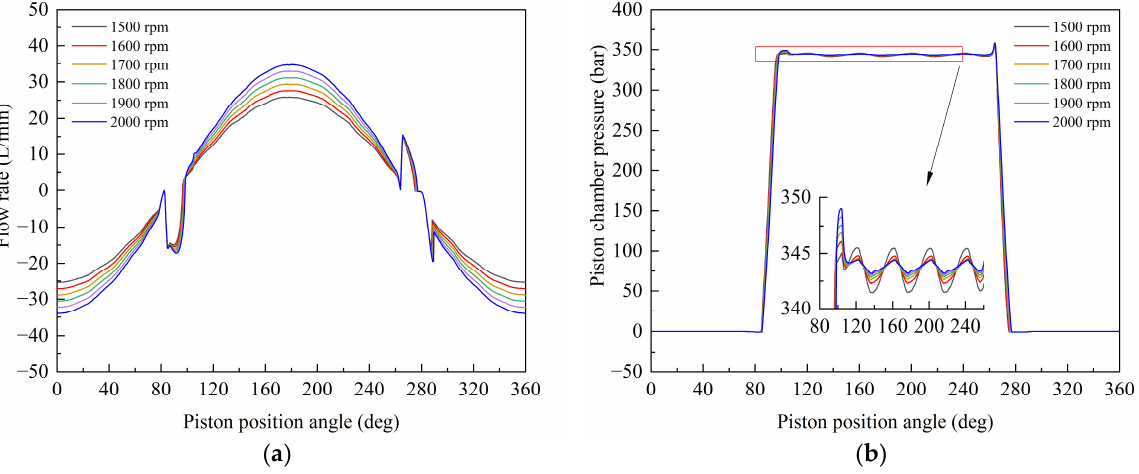
Figure 27. Flow and pressure characteristics of the piston chamber under different spindle speeds: ( a ) dynamic flow; ( b ) dynamic pressure.